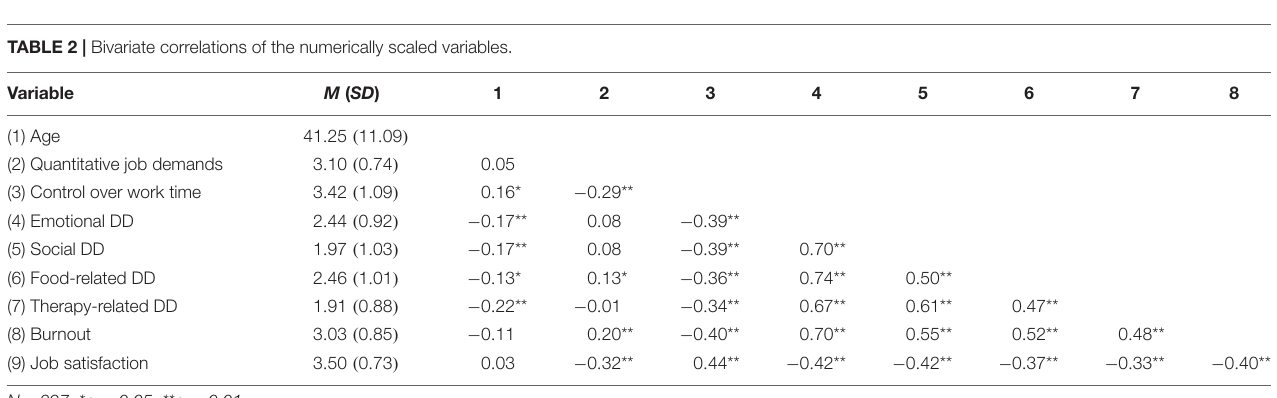
TABLE 2 | Bivariate correlations of the numerically scaled variables.